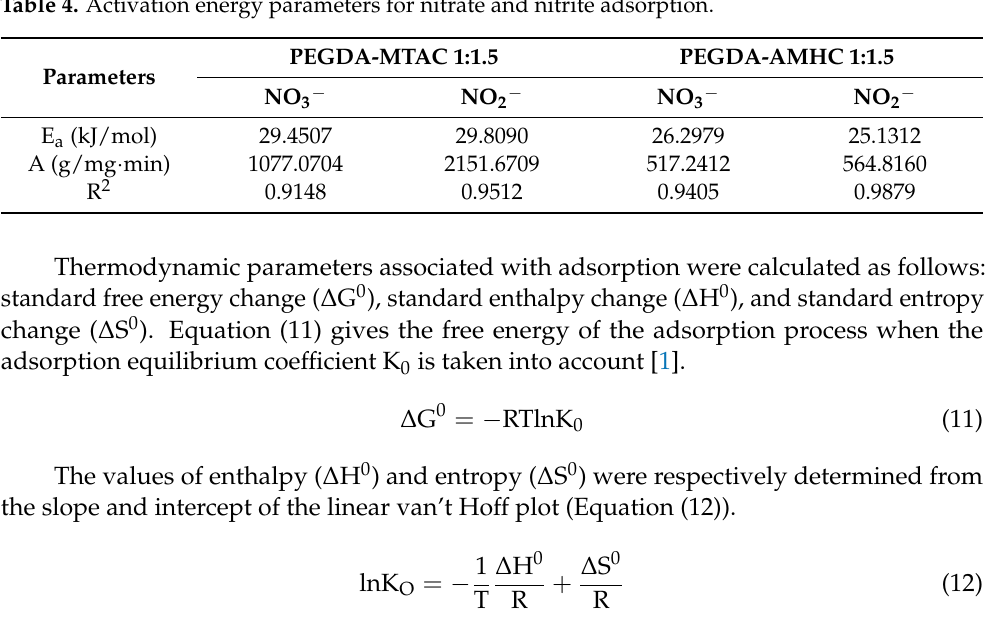
Table 4. Activation energy parameters for nitrate and nitrite adsorption.